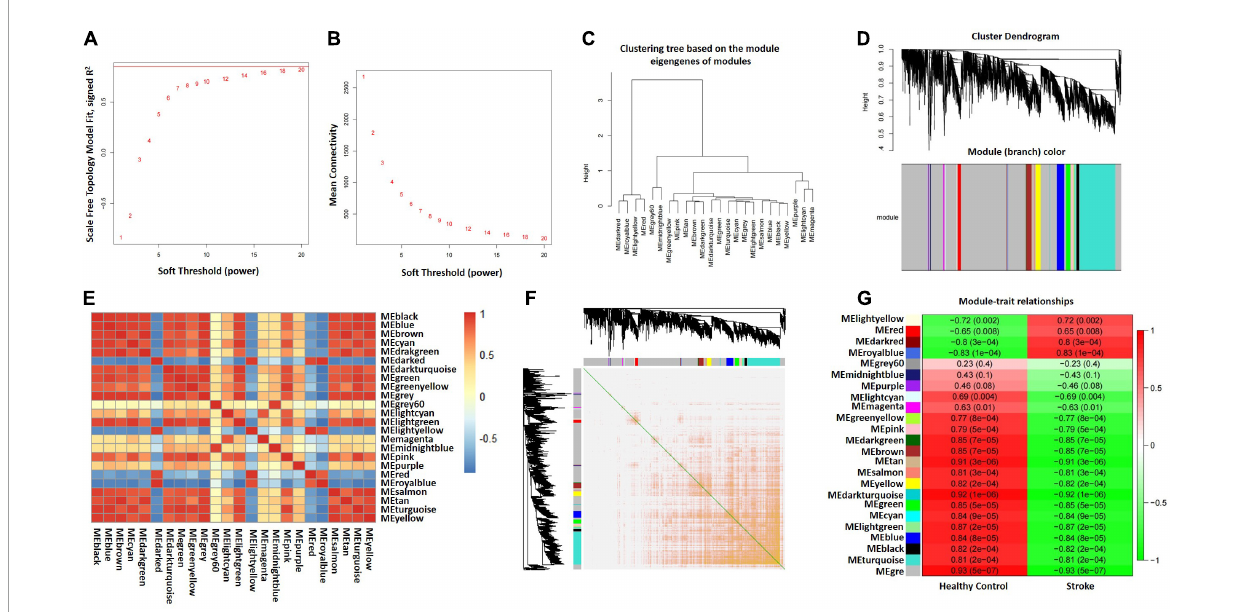
FIGURE3 Construction of WGCNA co–expression network. (A) Scale-free fit index. (B) Mean connectivity. (C) Clustered dendrograms. (D) Clustering dendrogram of genes, various colors represent different modules. (E) Correlation heatmap between modules. Red and blue represent positive and negative correlations, respectively. (F) Clustering dendrogram of module feature genes. (G) Heatmap of module–trait correlations. Red and green represent positive and negative correlations, respectively. HC, healthy control; WGCNA, weighted gene co-expression network